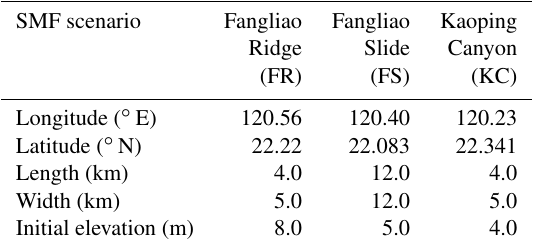
Table 2. Parameters of 1781 SMF